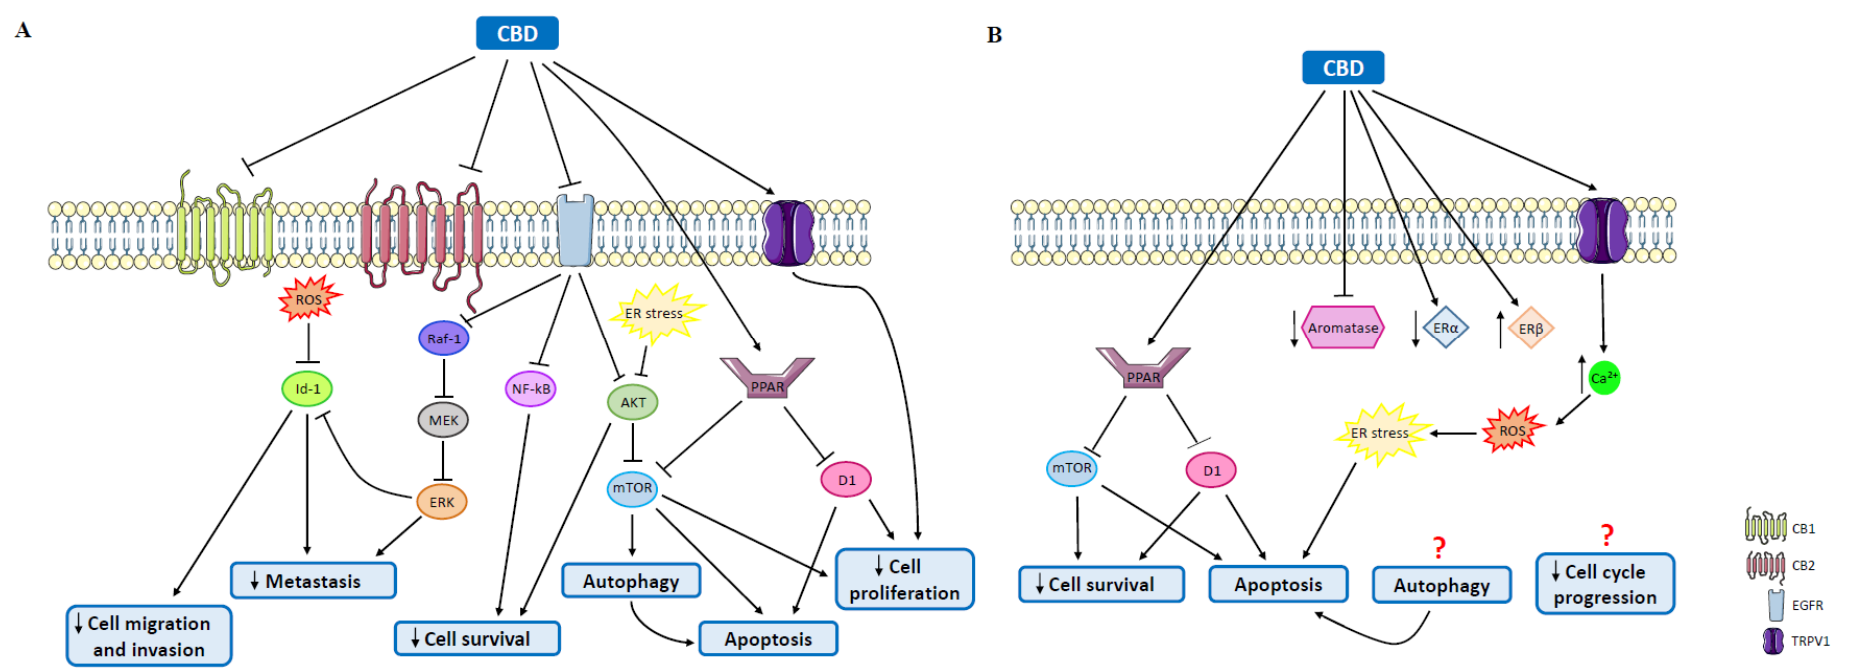
Figure 3. Antitumor effects mediated by CBD on TNBC and ER + breast cancer. ( A ) In TNBC, CBD decreases cell proliferation by activating TRPV1 and PPAR, through the inhibition of cyclin D1 and mTOR, promoting apoptosis, which is also caused by autophagy through the induction of endoplasmic reticulum stress, leading to the inhibition of AKT and mTOR signaling. The inhibition of EGFR decreases cell survival, through the inhibition of either AKT or NF-kB, and downregulation of the Raf-1/MEK/ERK signaling pathway, which decreases the metastatic potential directly or through the inhibition of Id-1. The latter can also be promoted by ROS. ( B ) In ER + breast tumors, CBD, through the activation of PPAR, induces inhibition of mTOR and cyclin D1, causing apoptosis and a reduction in cell survival. CBD can also induce apoptosis through the activation of TRPV1 via endoplasmic reticulum stress. CBD inhibits aromatase and decreases its protein levels, downregulates ER α and upregulates ER β . D1: cyclin D1; ER α : estrogen receptor α ; ER β : estrogen receptor β ; ER stress: endoplasmic reticulum stress; mTOR: mammalian target or rapamycin; PPAR: peroxisome proliferator-activated receptor; ROS: reactive oxygen species; TRPV1: transient receptor potential vanilloid 1; AKT: protein kinase B; CB1: cannabinoid receptor 1; CB2: cannabinoid receptor 2; EGFR: epidermal growth factor receptor; ERK: extracellular signal- regulated kinase; MEK: mitogen-activated protein kinase kinase; NF-kB: nuclear factor kB; Raf-1: proto-oncogene Raf-1.